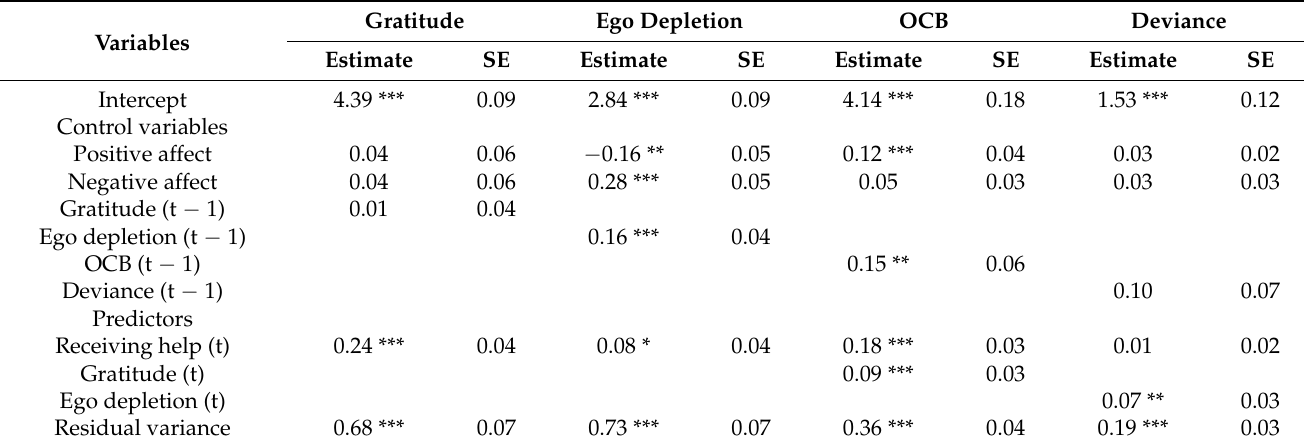
Figure 2. Unstandardized estimates of path coefficients. Note. OCB, organizational citizenship behavior. Solid lines, statistically significant paths; dashed lines, statistically nonsignificant paths. * p < 0.05, ** p < 0.01, *** p < 0.001. Table 3. Multilevel path analysis results.